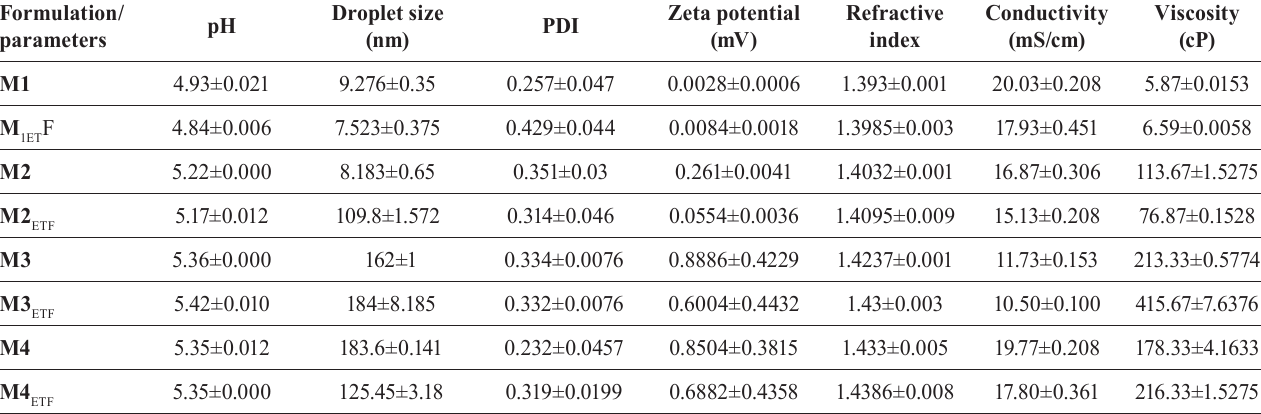
TABLE III - Characterization of the developed blank and ETF-loaded microemulsion formulations (mean ± SD, n=3) Formulation/ parameters